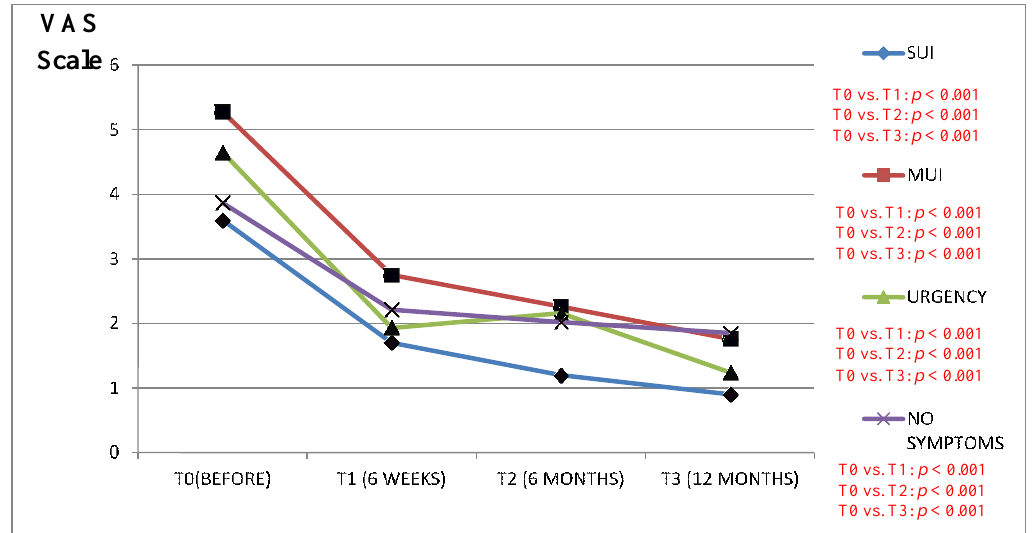
Figure 4. Impact of the vaginal native tissue repair (VNTR) on bulging in everyday functioning—according to the visual analogue scale (VAS).